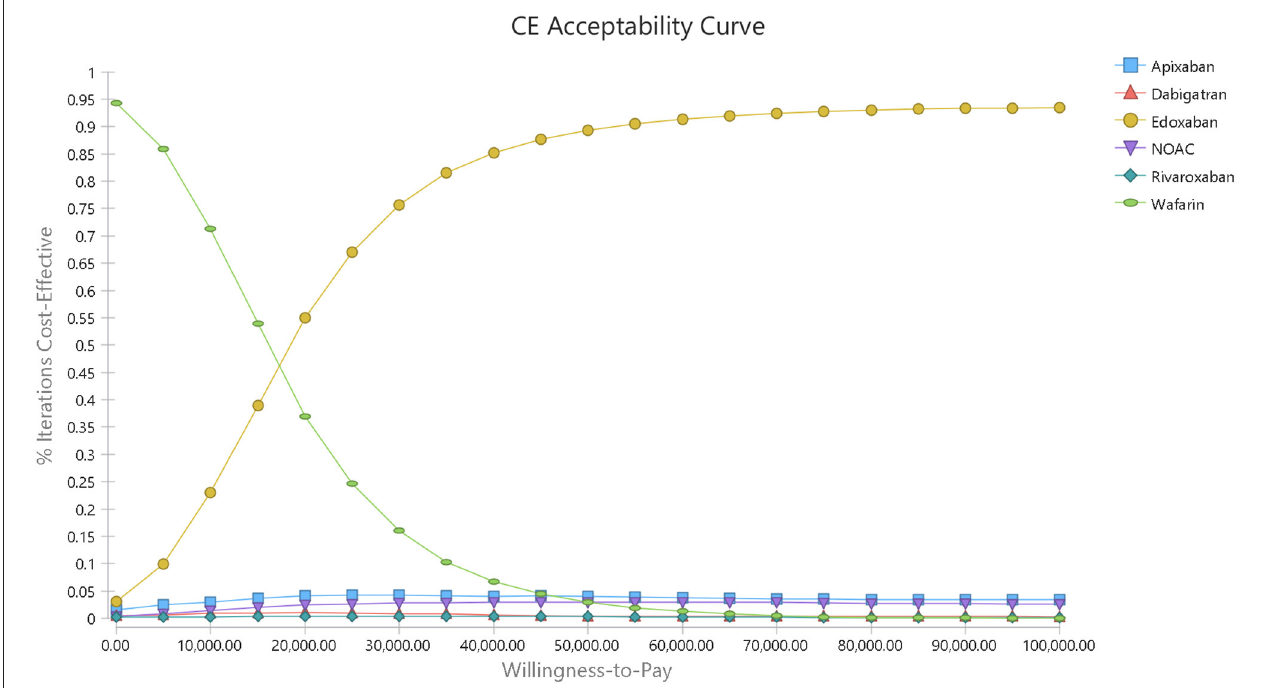
FIGURE 5 | Willingness-to-pay